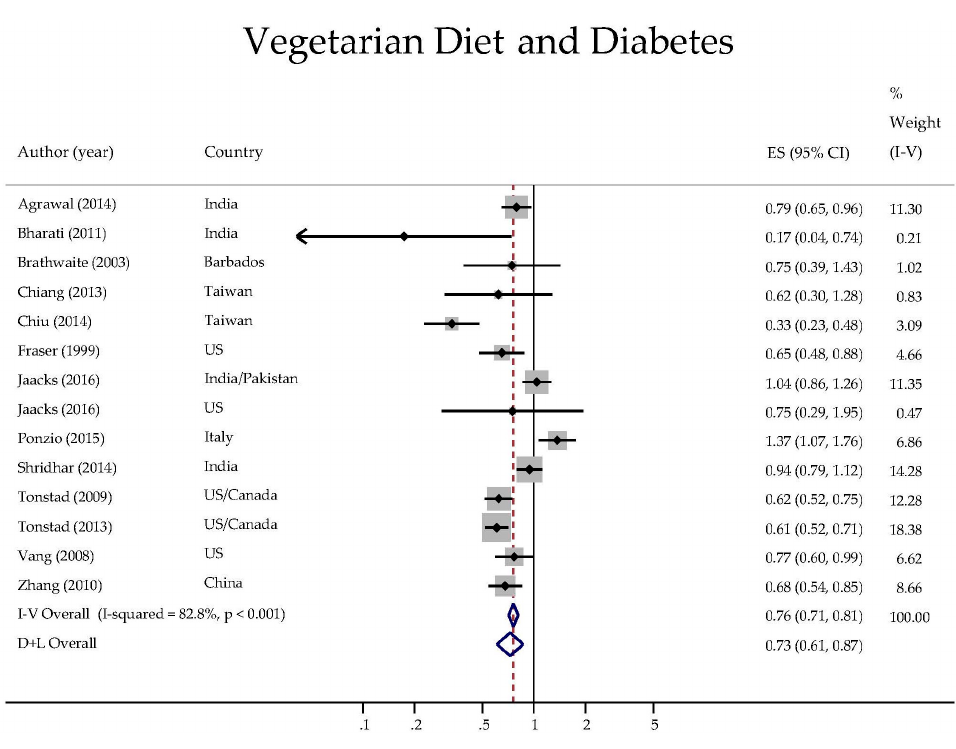
Figure 2. Forest plot of the pooled odds ratios of the association between a vegetarian diet and the prevalence or incidence of diabetes. Table 1. Pooled odds ratios and 95% confidence intervals for the assocation between a vegetarian diet and diabetes risk by